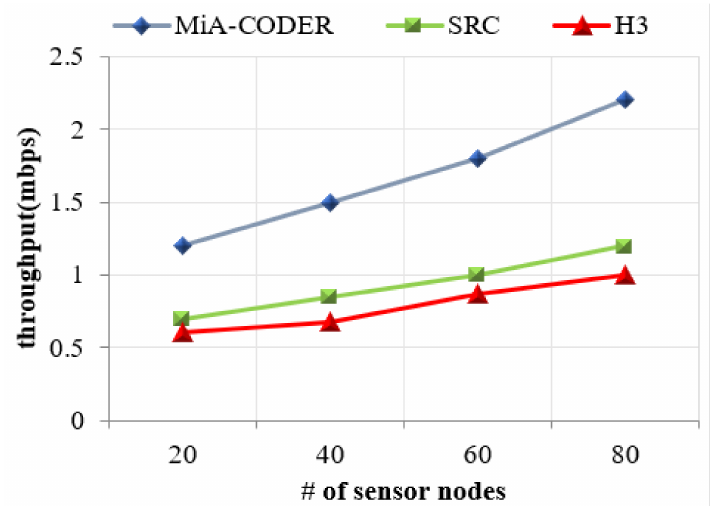
Figure 9. Number of sensor nodes vs.